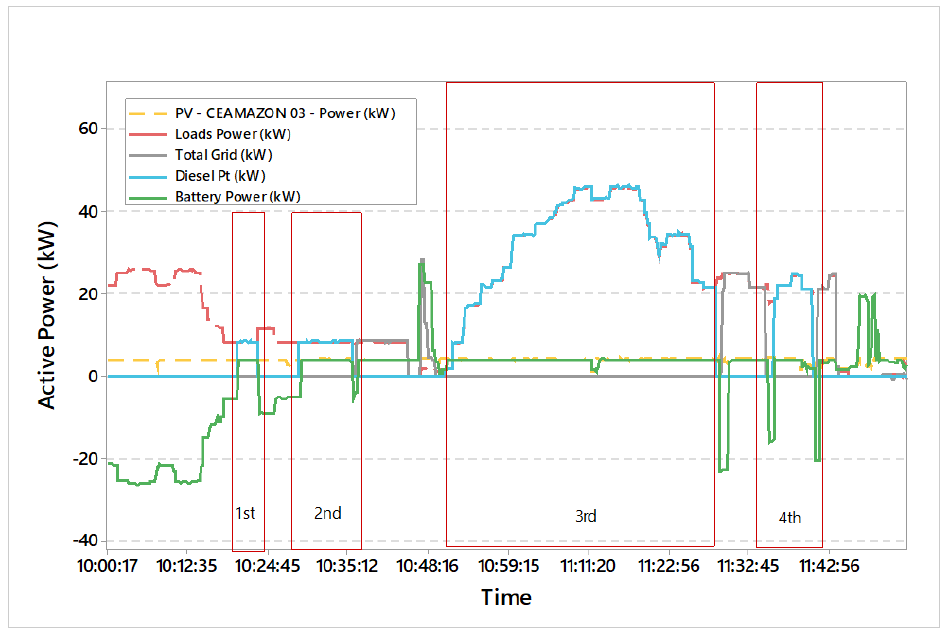
Figure 18. Diesel generator operation in off-grid condition.